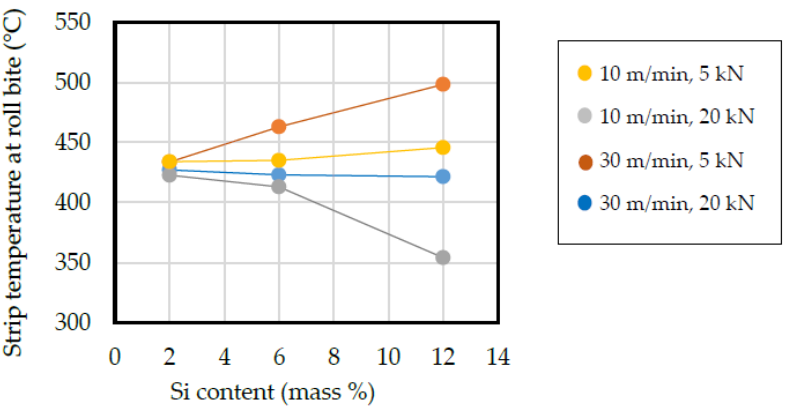
Figure 5. Effects of roll speed, roll load, and Si content on strip temperature at roll bite. Roll speed: 10 m/min and 30 m/min; roll load: 5 kN and 20 kN; Si content: 2%, 6%, and 12%.